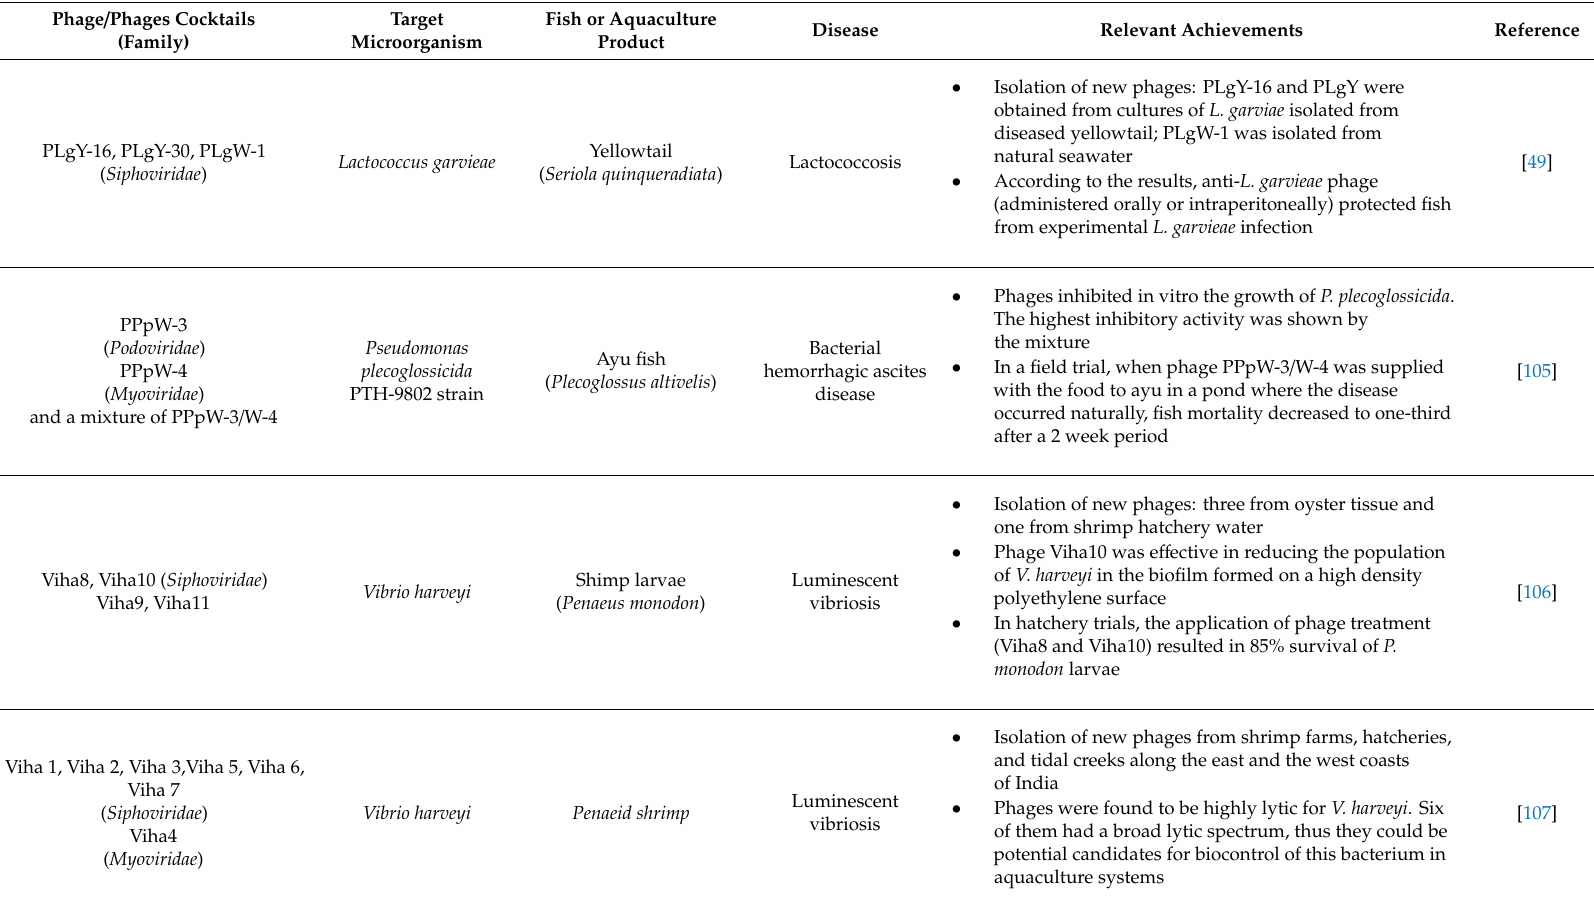
Table 2. A selection of phages reported for the biocontrol of pathogens in